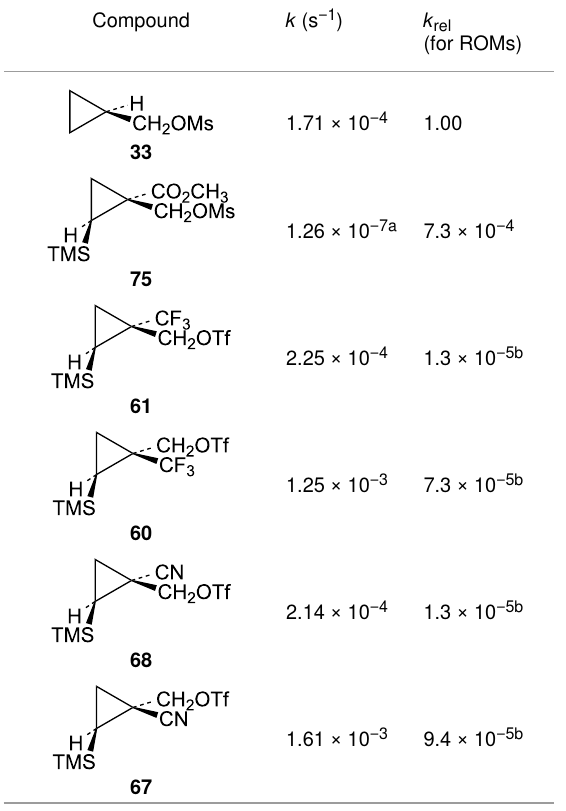
Table 2: Solvolysis rates for substrates in CD 3 CO 2 D at 20.0